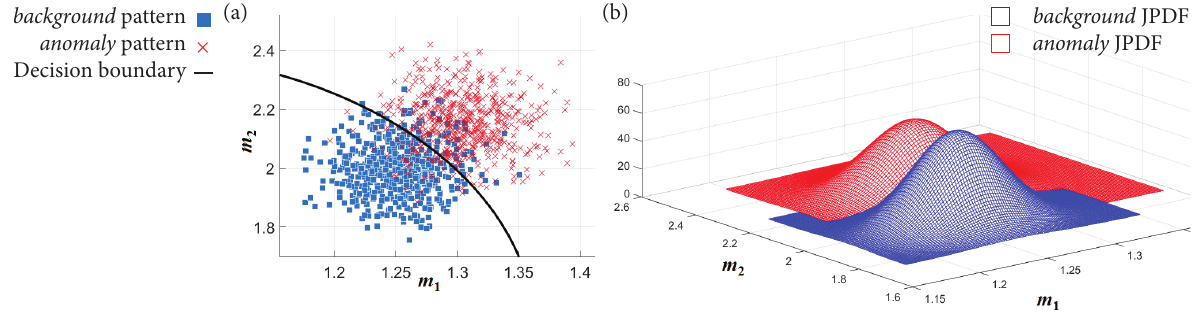
Figure 6. Decision boundary (a) for σ = 1, A = 0,4, and joint probability density functions (JPDF) (b) for both